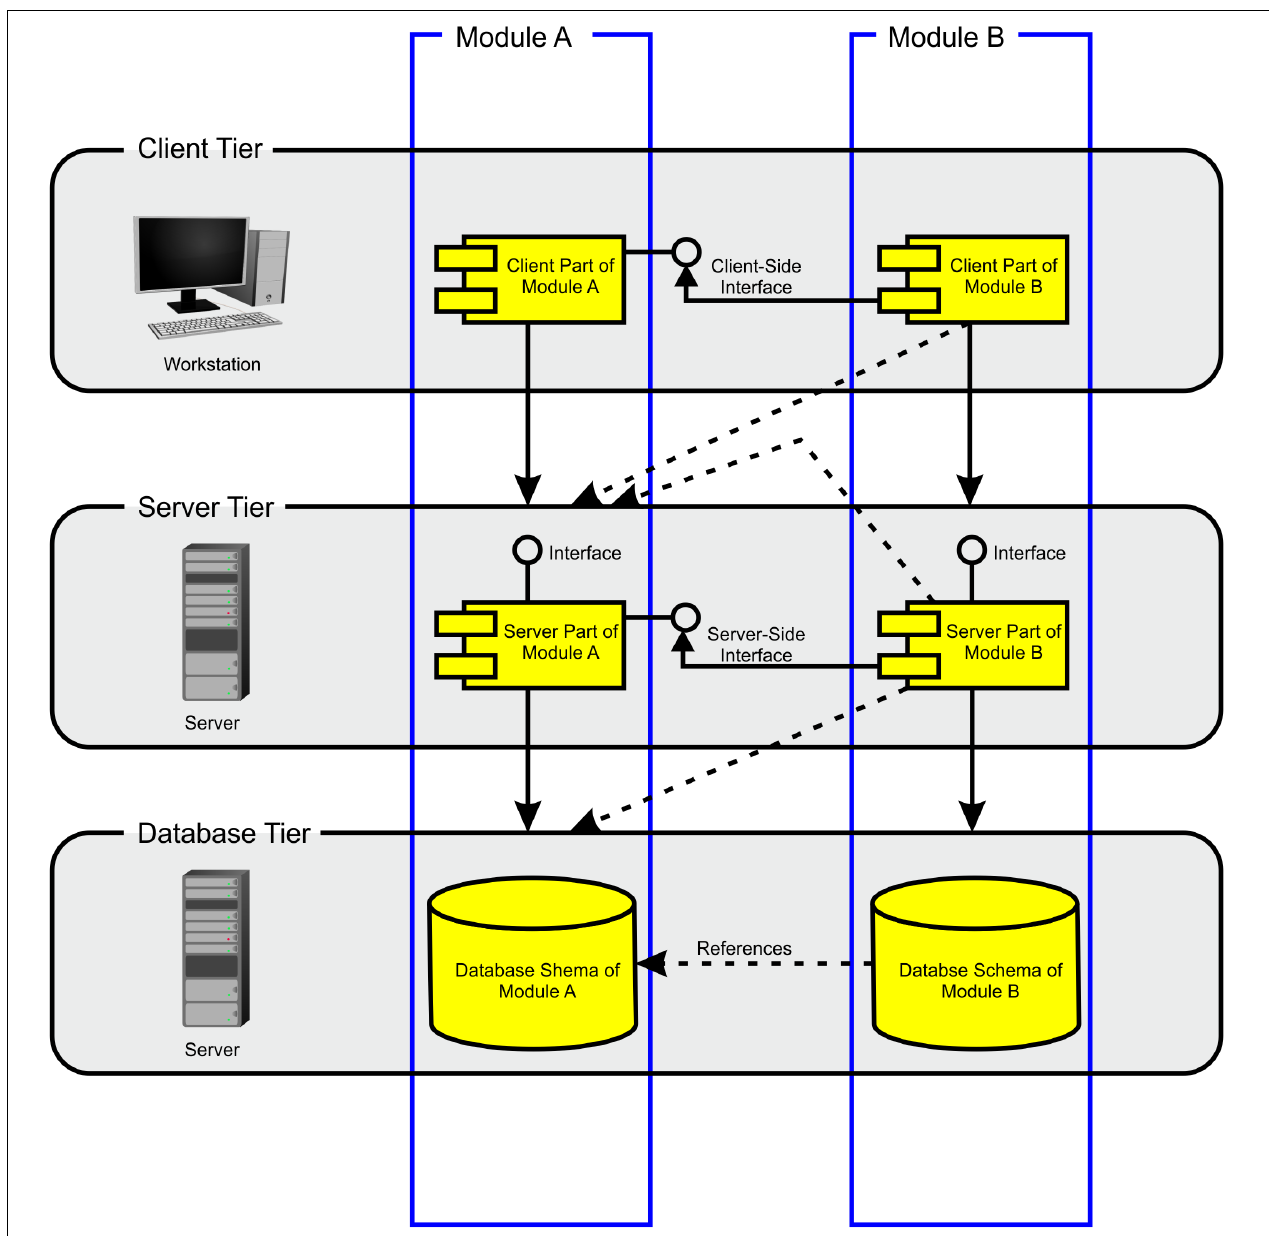
FIGURE 3 | Modules architecture. The BioXM platform consists of three tiers: client, server, and database. The database tier contains all the database schemes. The user does not directly access databases, but works through a Java R (cid:13) client that enables setting up the knowledge model, import data and to query the knowledge model. The server tier mediates between the user and the database tier. There is a module which defines the functionality for each object kind from user input to database access. There are interfaces between modules on the client and the server tiers (solid lines). Modules are cross-referenced on the database tier and between different tiers (dashed lines) enabling cross-referencing and querying multiple data